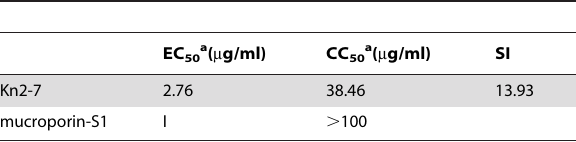
Table 2. Anti-HIV-1 PV activities and cytotoxicity of Kn2-7 peptide on TZM-bl